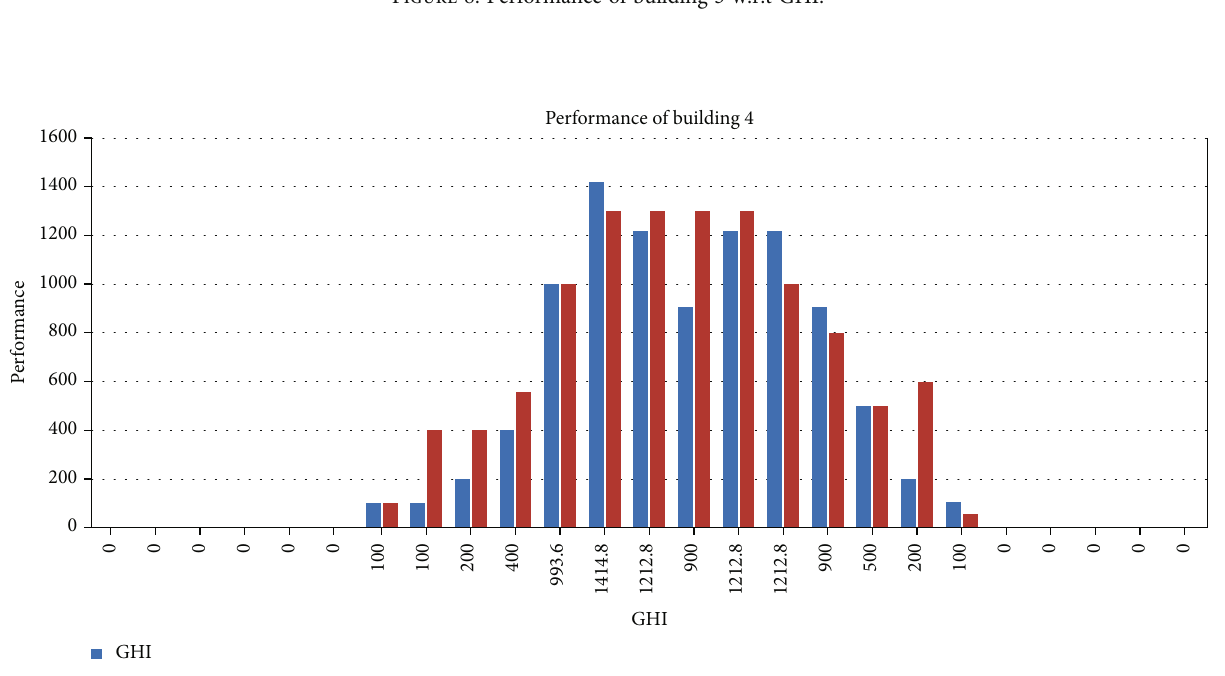
Figure 8: Performance of building 3 w.r.t GHI.